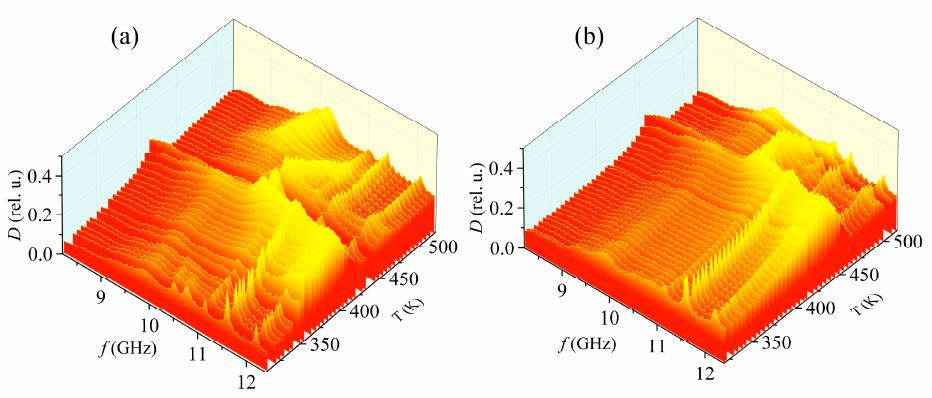
Figure 13. Dependence of absorption coefficient SS of composition 0.97PbZrO 3 –0.03PbTiO 3 on frequency and temperature during heating ( a ) and cooling ( b ). Three-dimensional diagrams show the general dynamics of changes in the absorption coefficient. The color is chosen for contrast, and to make this 3D pattern easier to associate with 2D heat maps.